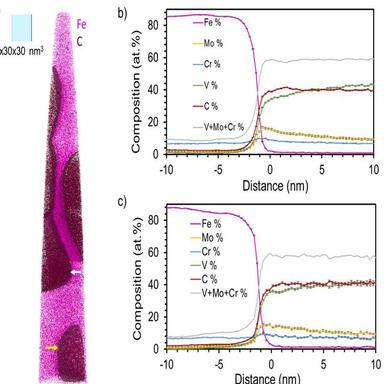
APT analysis on 85% binder saturated H13. (a) APT reconstructions showing carbides, and the proximity histograms across (b) the interconnected carbides (white arrow) and (c) individual bottom carbide (yellow arrow), respectively.